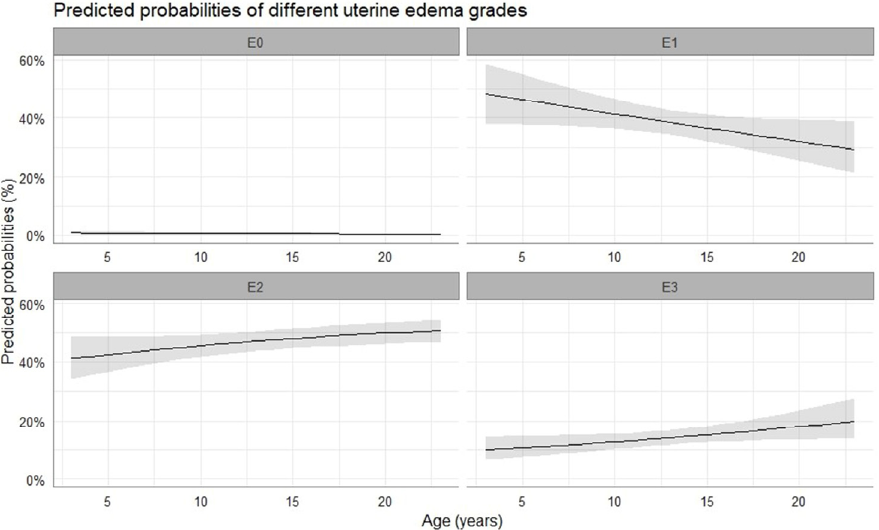
Figure 4. Mean probability (solid line) and the respective 95% confidence intervals (grey-shaded area) for the occurrence of uterine edema with progressing age of the mare. E0, no edema; E1, low-grade edema; E2, moderate edema; E3, marked edema.